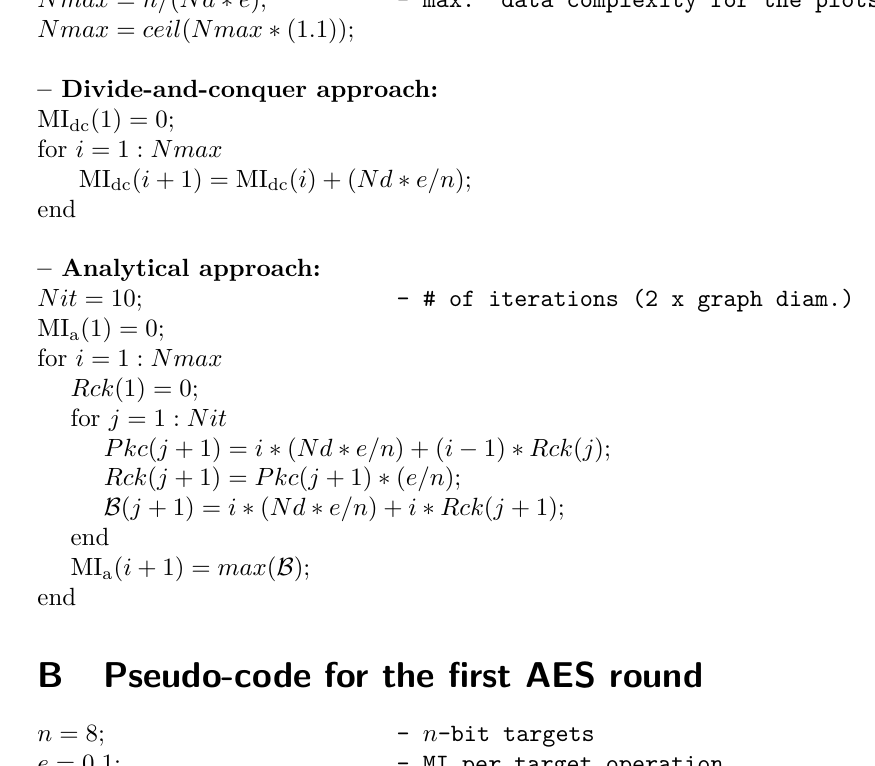
data complexity for the